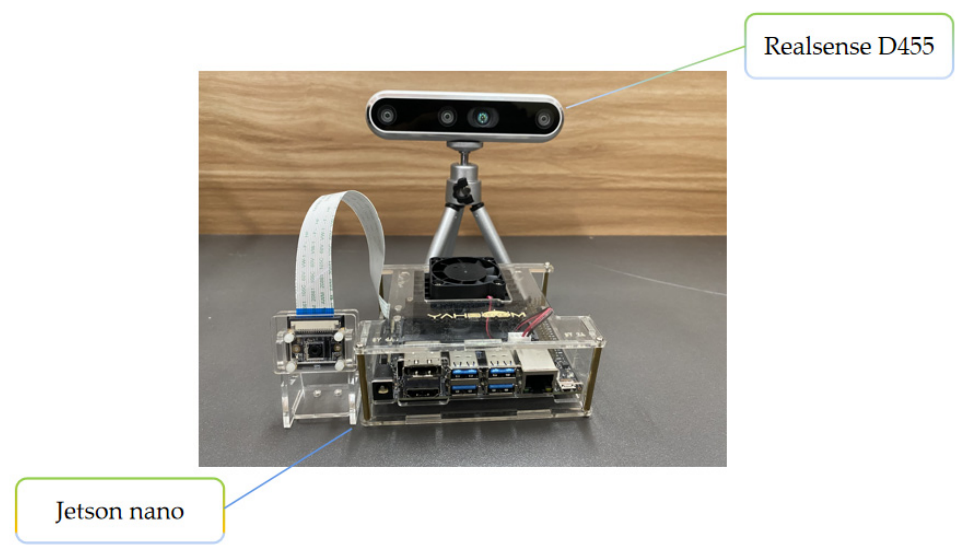
Figure 1. Image-recognition embedded module.